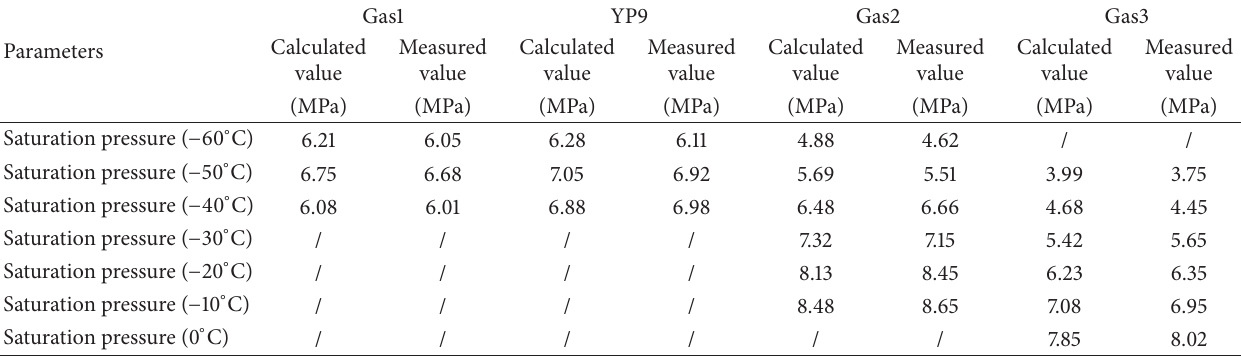
Table 4: Saturation pressure calculated by using the model proposed in this paper and experimental measured saturation pressure.